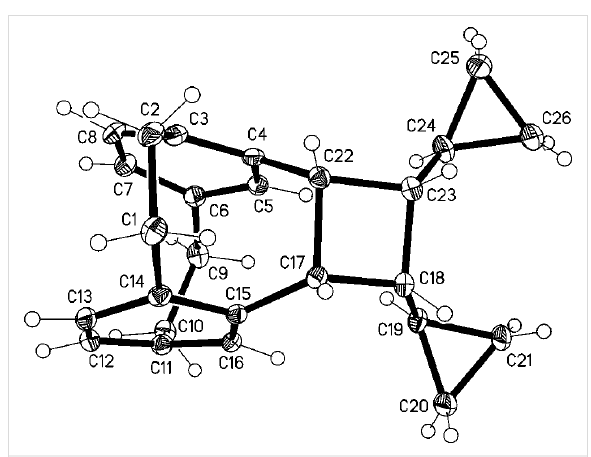
Figure 4: The molecule of compound 23 in the crystal. Ellipsoids correspond to 50% probability